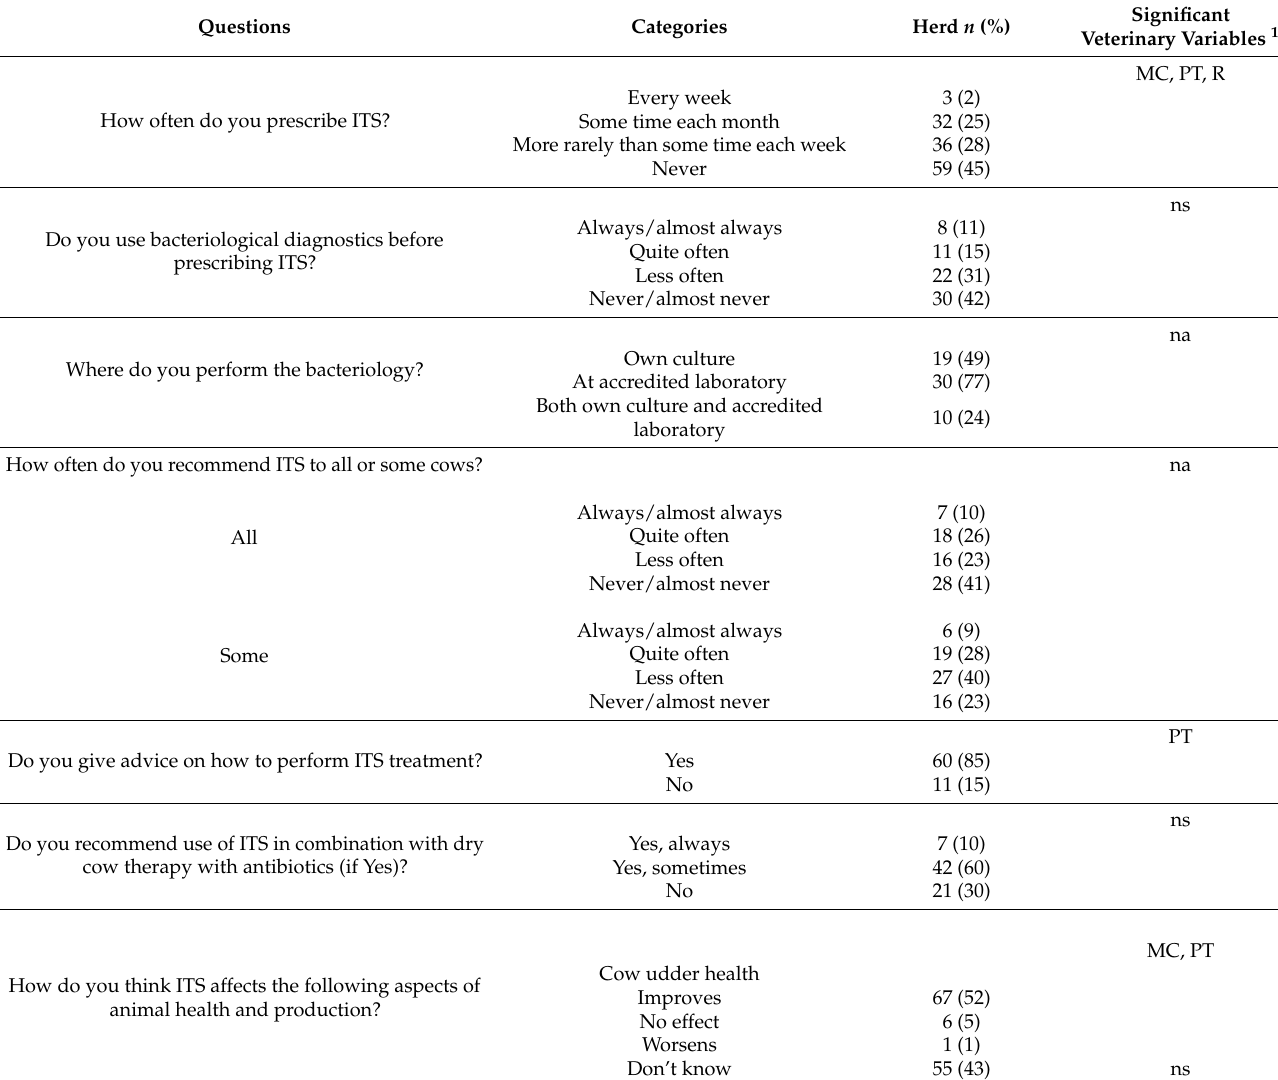
Table 6. Responses to questions about advice regarding treatment of dairy cows with internal teat sealants (ITS) at drying-off given by veterinarians ( n = 130) participating in a web-based questionnaire. The associations between veterinary variables and the answers were investigated using univariable regression models and if significant ( p ≤ 0.05) the veterinary variables are